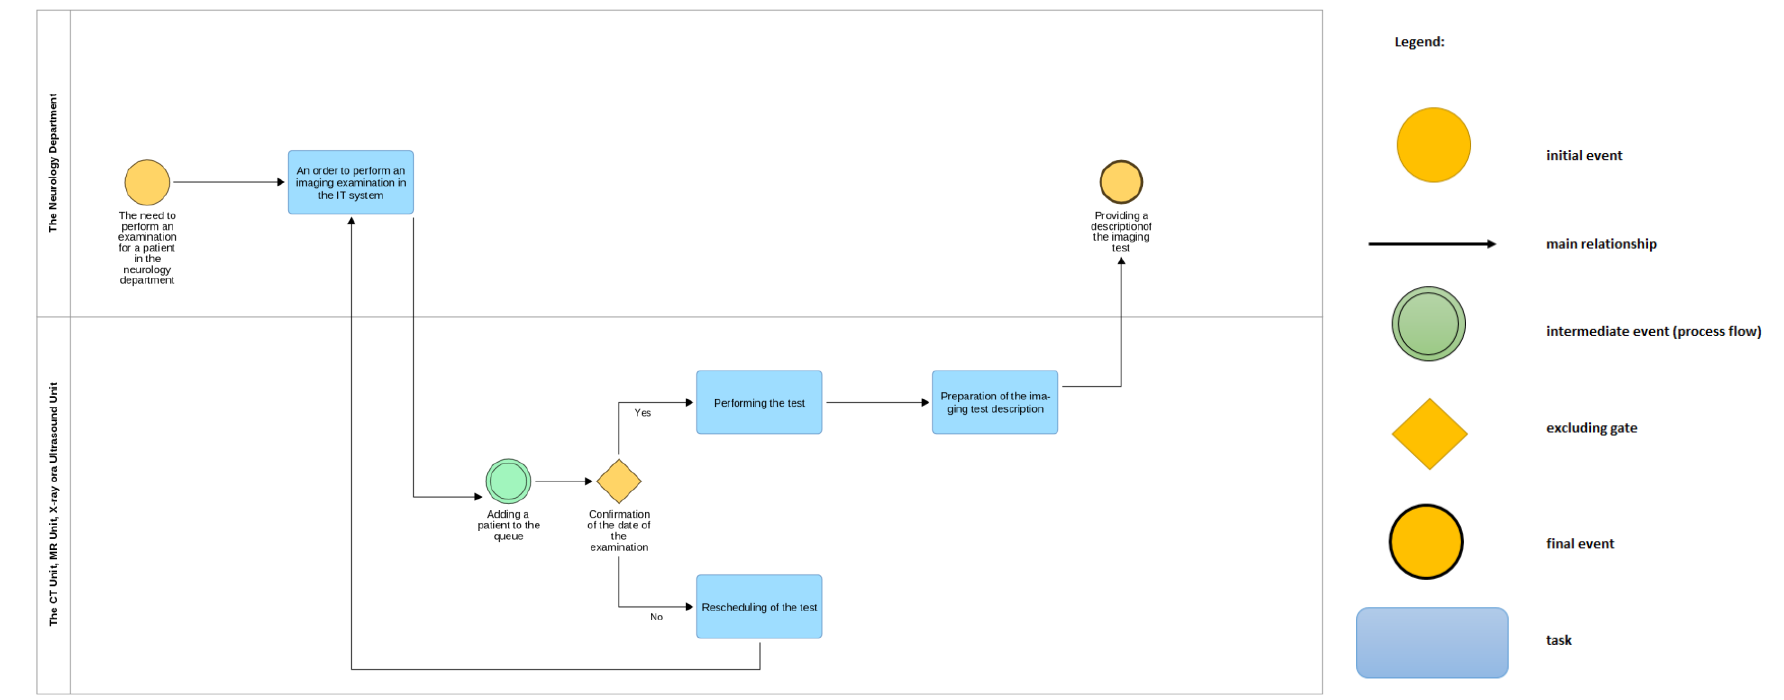
Figure 4. The new flowchart of the imaging scan scheduling.